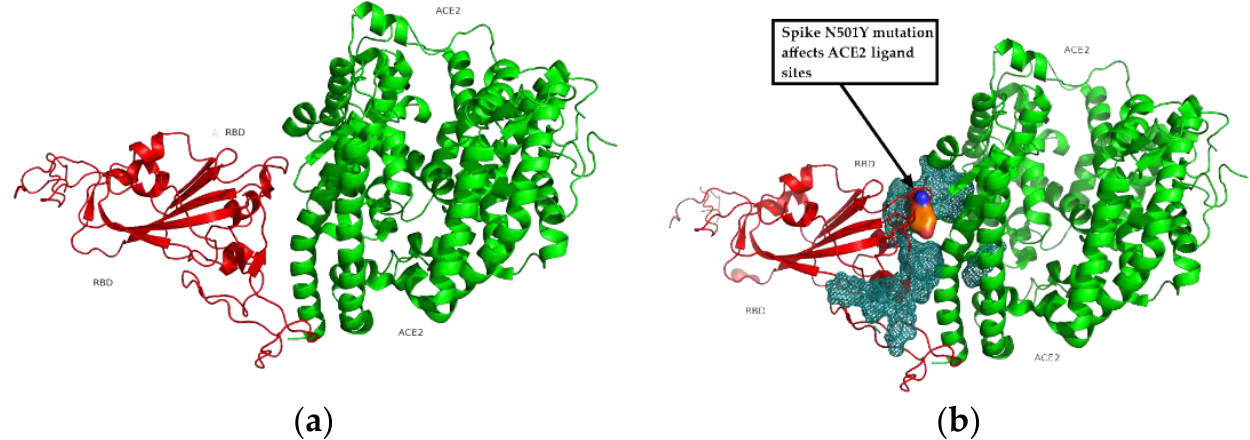
Figure 6. Interaction between binding receptor domain from spike protein and ACE2 receptor. ( a ) Spanish variant. ( b ) British variant.